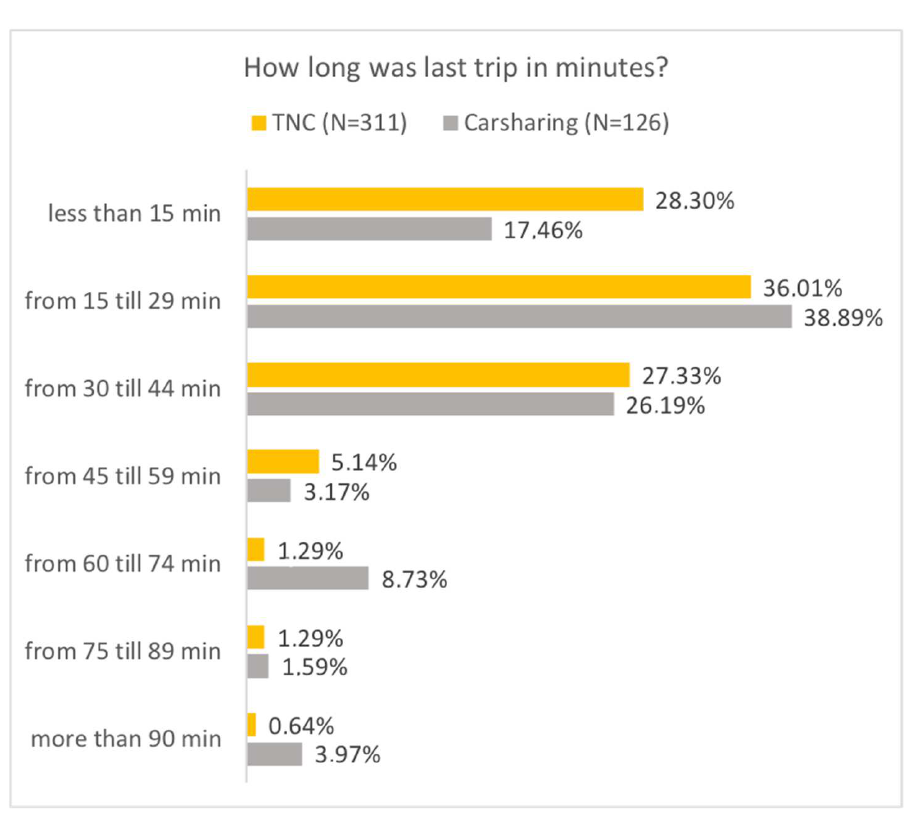
Figure 5. Duration of the last trip of car-sharing and TNC of respondents.